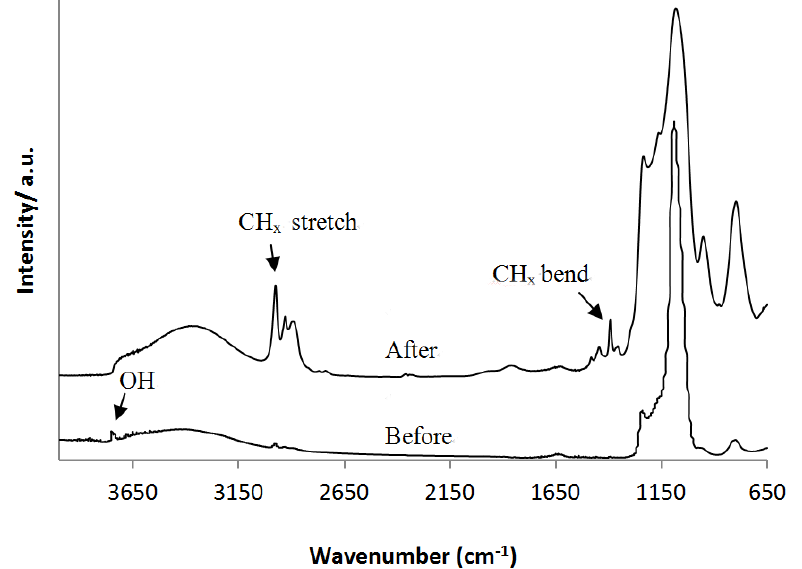
Figure 3. Diffuse reflectance infra-red Fourier transform (DRIFT) spectrum of MCM-41 before and after